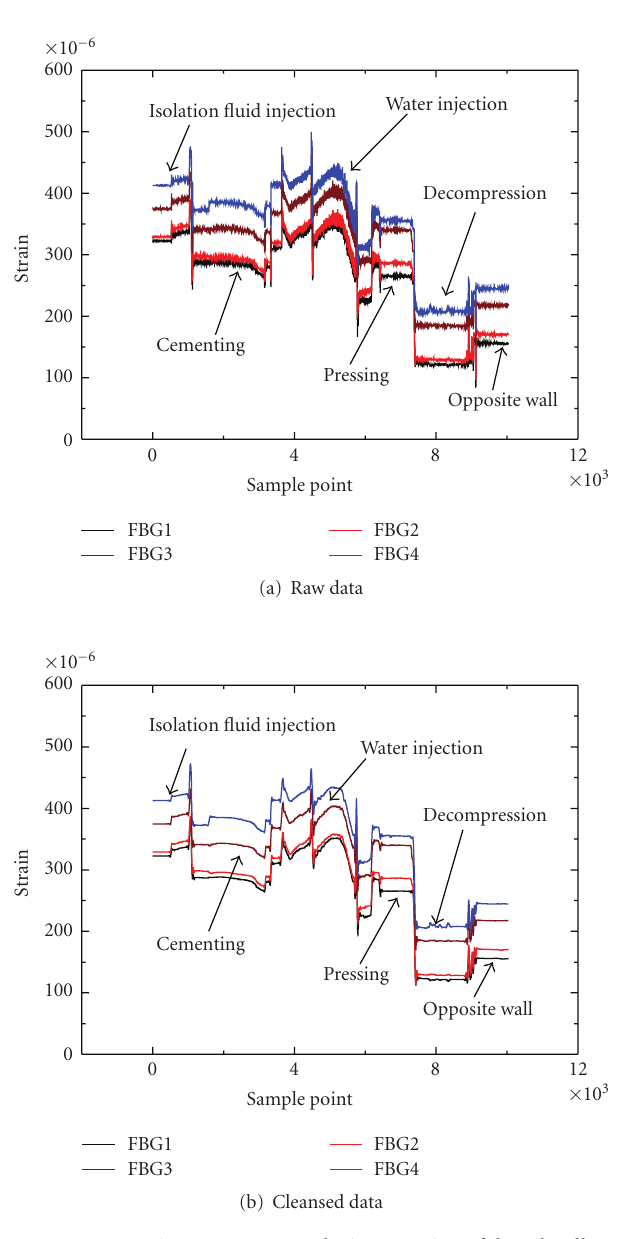
Figure 9: Strain measurements during grouting of the oil well.